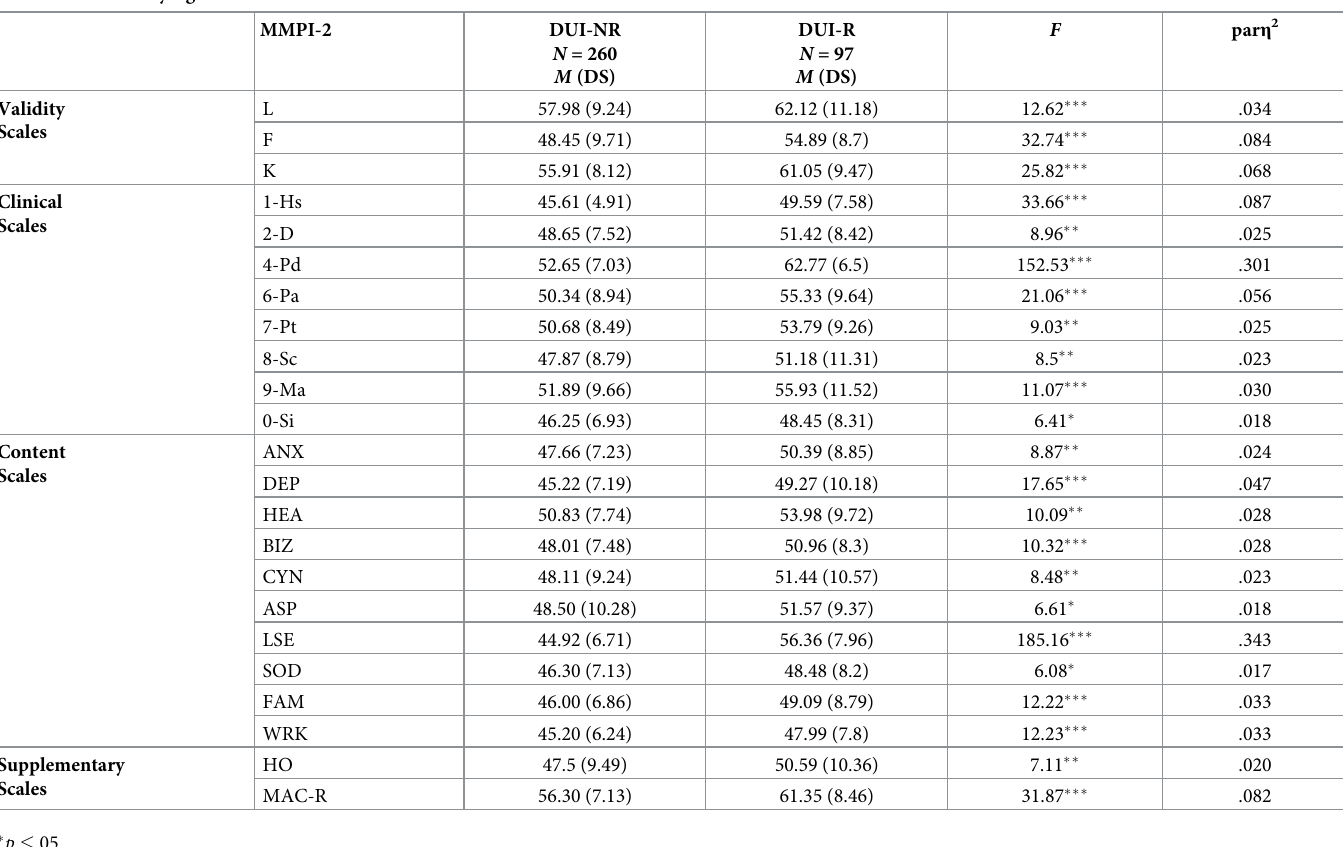
Table 3. Statistically significant differences in MMPI-2 scales between DUI-NR and